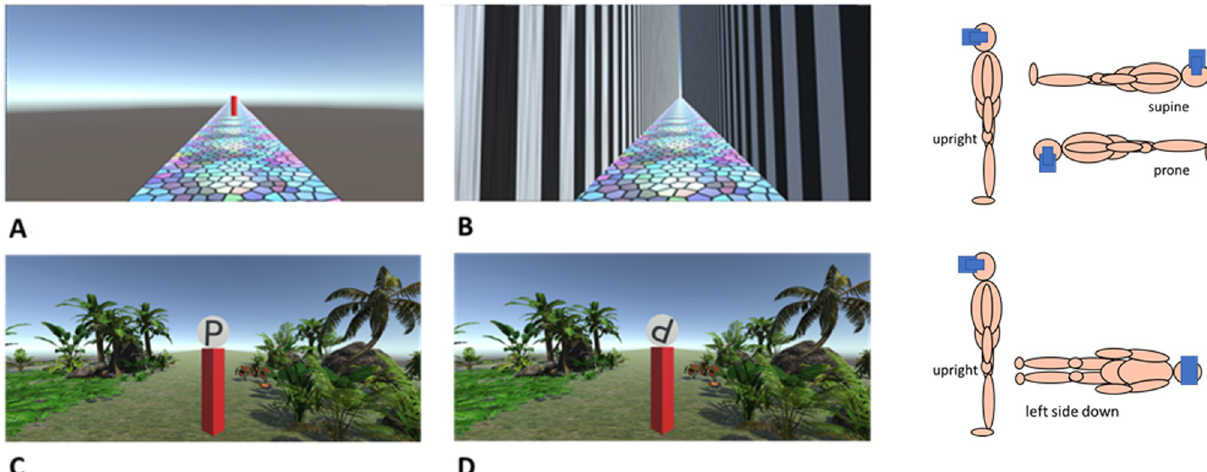
Fig 2. Screen captures of the different environments used in this experiment. (A) is the hallway shown while the target is visible and the walls are invisible, and (B) is the hallway once the participant has clicked the left mouse button and they are beginning to move. (C) is an example of the upright (0 degree) visual scene in the OChaRT environment. (D) Is the same visual scene as C but with the ambiguous p/d shape at a different orientation. The cartoons on the right-hand side of the image show the different body postures that were used when completing the different tasks in each environment. The people are wearing HMDs. In the hallway environment depicted in panels A and B, the upright, supine, and prone postures were used. In the OChaRT environment depicted in panels C and D, the upright and left side down postures were used.